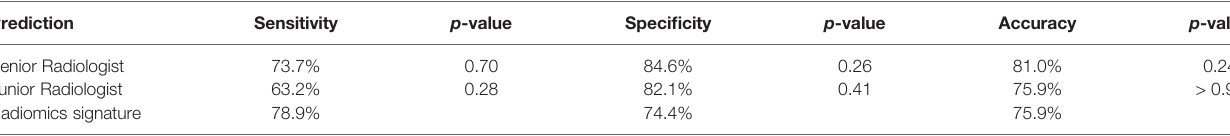
TABLE 3 | Comparison of the radiomics signature and radiologists on the validation cohort.